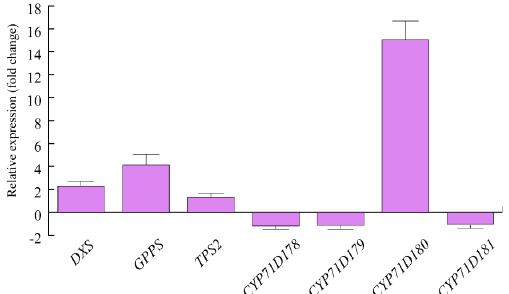
Figure 1. Levels of gene expression in Origanum vulgare leaves upon Spodoptera littoralis herbivory. Data are expressed as fold change (herbivory vs. control). CYP71D180 = one of the 4 cytochrome P450 isoforms possibly involved in carvacrol biosythesis, isolated from O. vulgare ; TPS2 : γ -terpinene synthase, isolated from O. vulgare and involved in the production of several monoterpenes, including the potential precursors of carvacrol; CYP71D178 and CYP71D179 = cytochrome P450 isoforms possibly involved in carvacrol biosynthesis, isolated from O. vulgare ; DXS : Deoxyxylulose phosphate synthase; GPPS : Geranyldiphosphate synthase. Three technical replicates were run for each biological replicate. Metric bars indicate standard deviation.